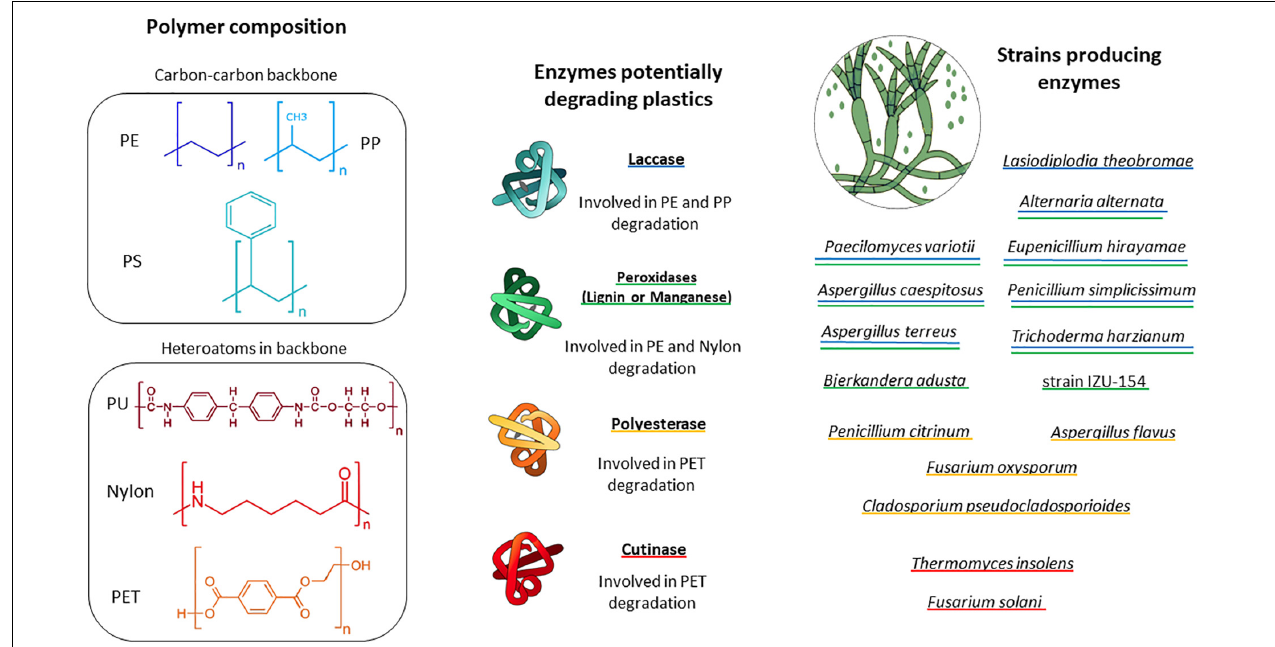
FIGURE 1 | Schematic of important plastic types encountered in the marine environment. Fungal enzymes and fungal groups potentially involved in plastic degradation are displayed. Blue underline indicates fungi producing laccase. Green underline indicates fungi producing peroxidase, Yellow underline indicates fungi producing polyesterase and red underline indicates fungi producing cutinase. PE, polyethylene; PP, polypropylene; PS, polystyrene; PU, polyurethane; Nylon, polyamides; PET, polyethylene